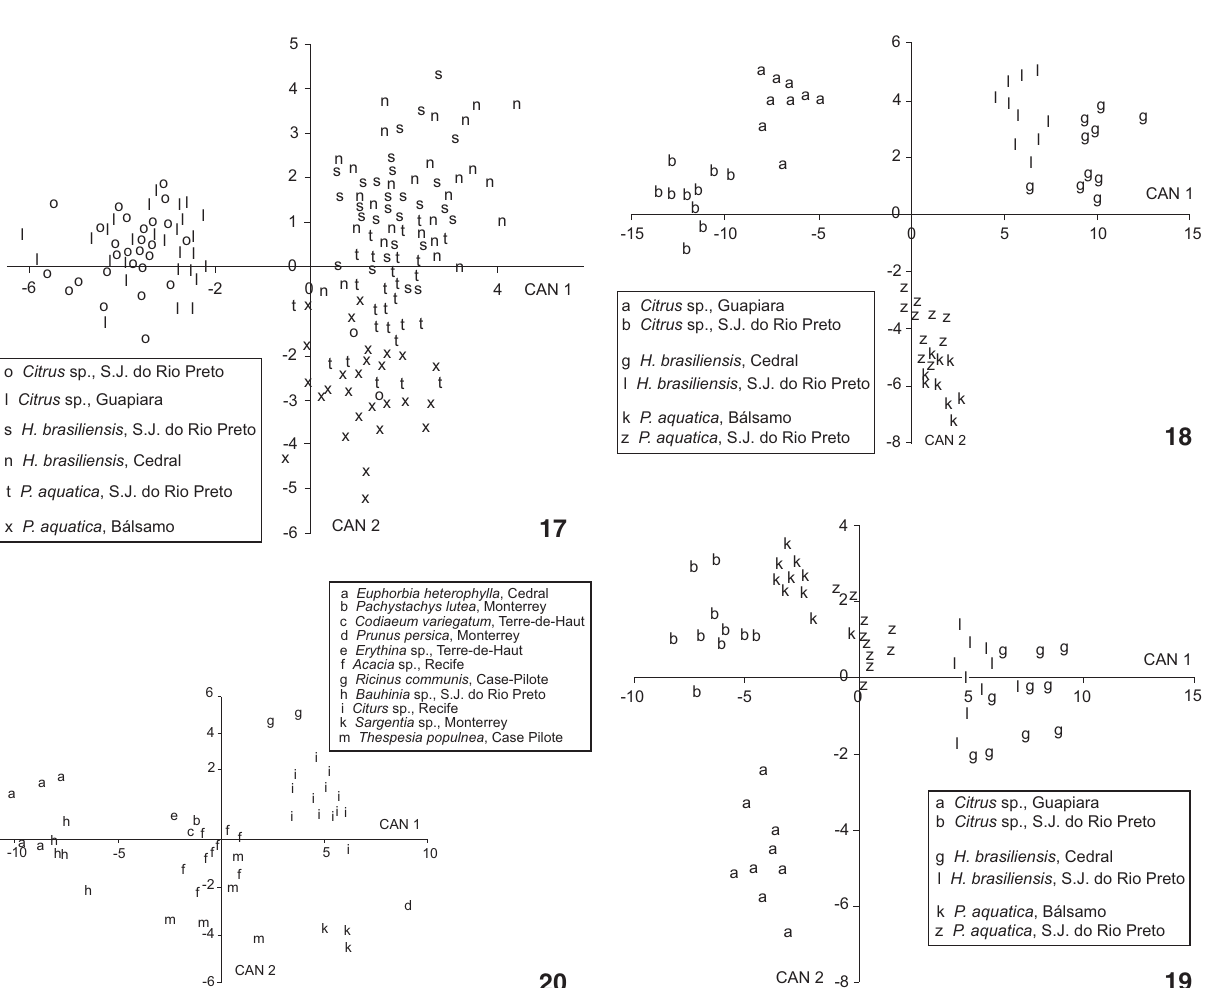
figura anterior; (19) combinação 3 para as mesmas fêmeas da figura anterior; (20) combinação 1 para 52 fêmeas de hospedeiros no Brasil, Guadalupe, Martinica, México e